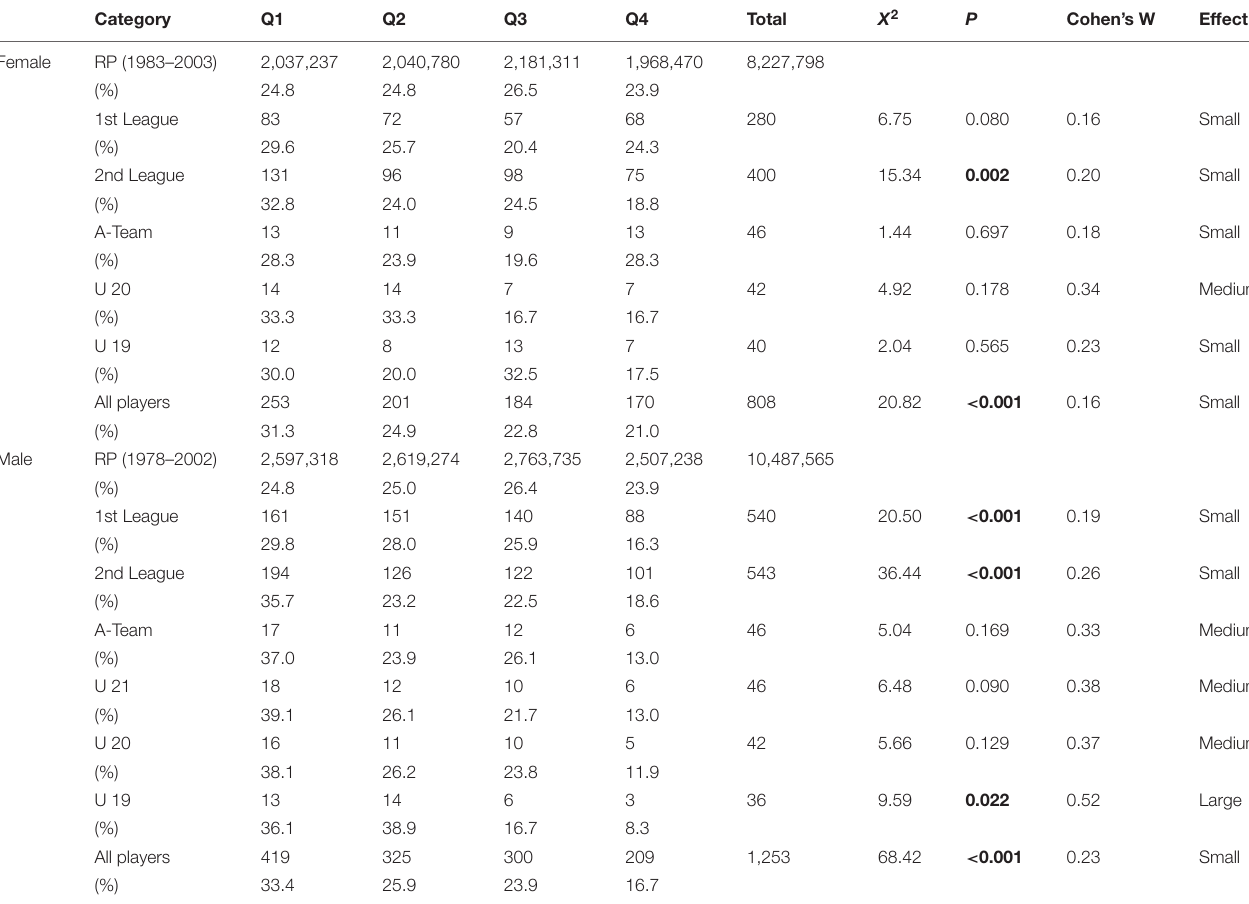
TABLE 2 | Birthdate distribution of the female and male elite adult soccer players compared to the corresponding reference population. Category Q1